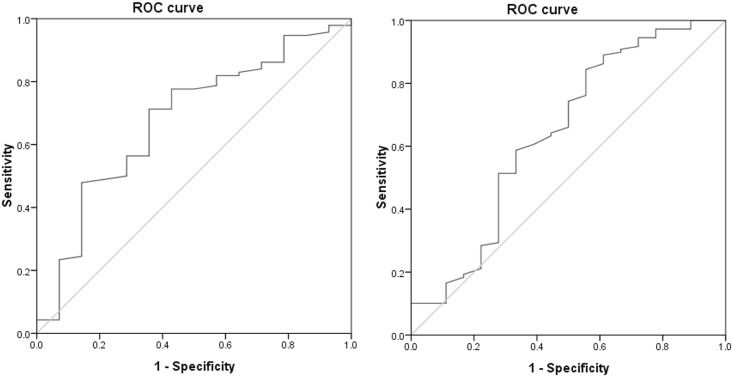
ROC analysis of peak VO2, Peak CPO(Left panel: peak CPO; Right panel: peak VO2).The area under ROC Curve of peak CPO for predicting cardiac-related deaths was 0.68 (Ρ<0.05), and the sensitivity and specificity were 0.713 and 0.650 respectively, which is significantly more sensitive than peak VO2 (the sensitivity was 0.590 and the specificity was 0.667). The optimal threshold of peak CPO for predicting cardiac-related deaths was≤ 1.1W and the optimal threshold of peak VO2 for predicting cardiac-related deaths was ≤13.4 ml.kg-1.min-1 in Chinese CHF patients.